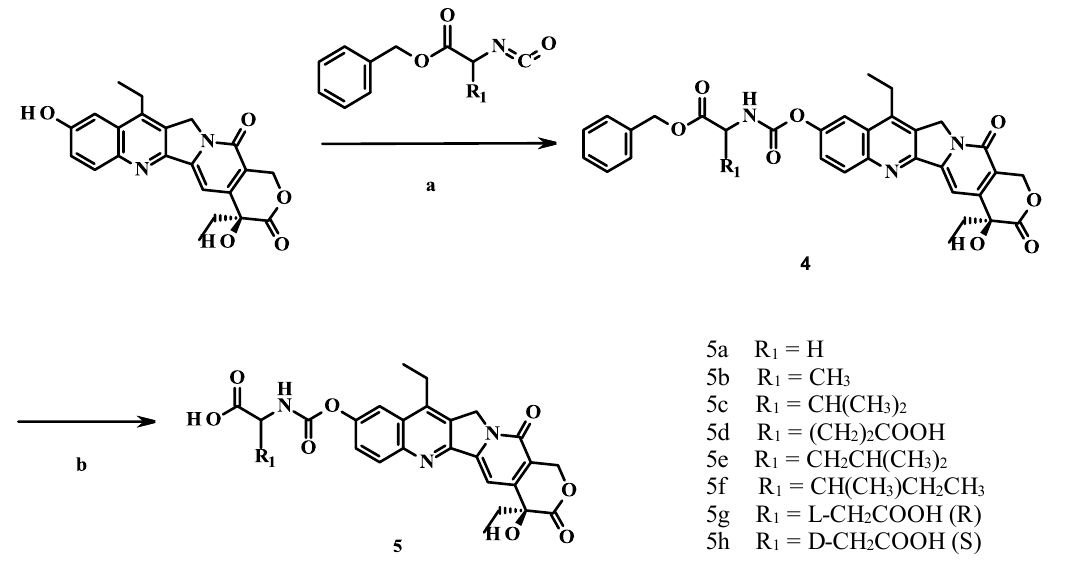
Scheme 1. Synthesis of prodrugs 5a – h